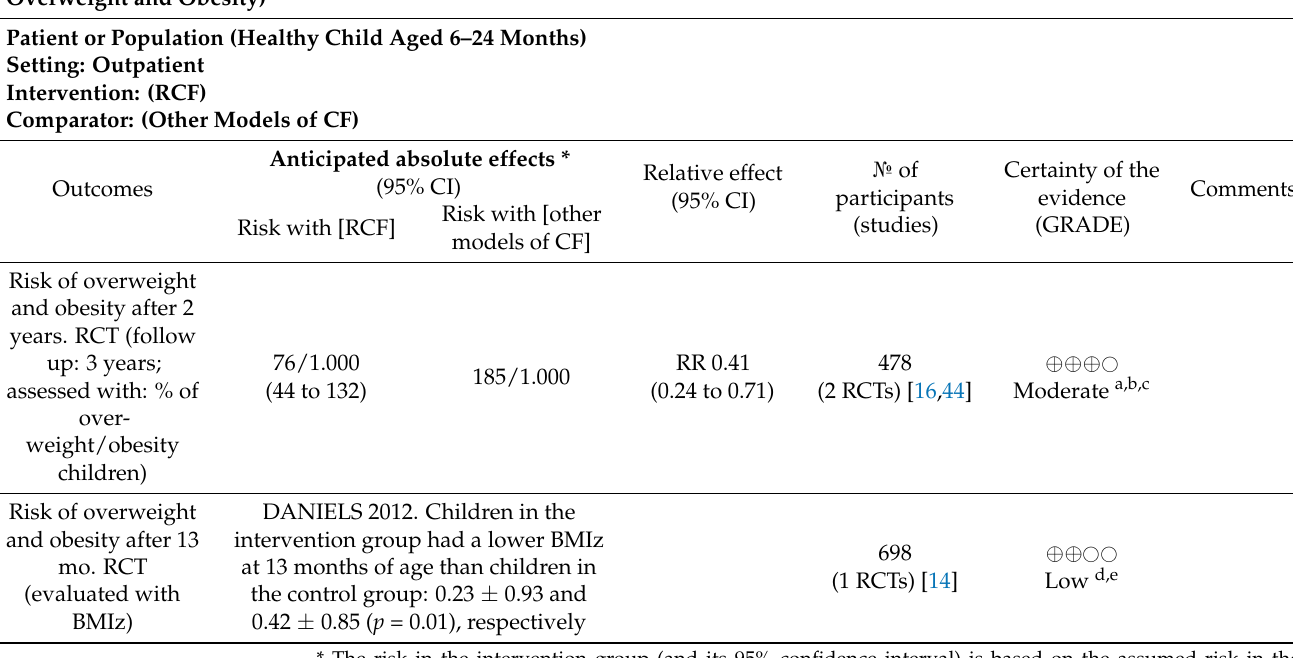
Table 3. RCF and risk of overweight/obesity. Summary of findings for the main